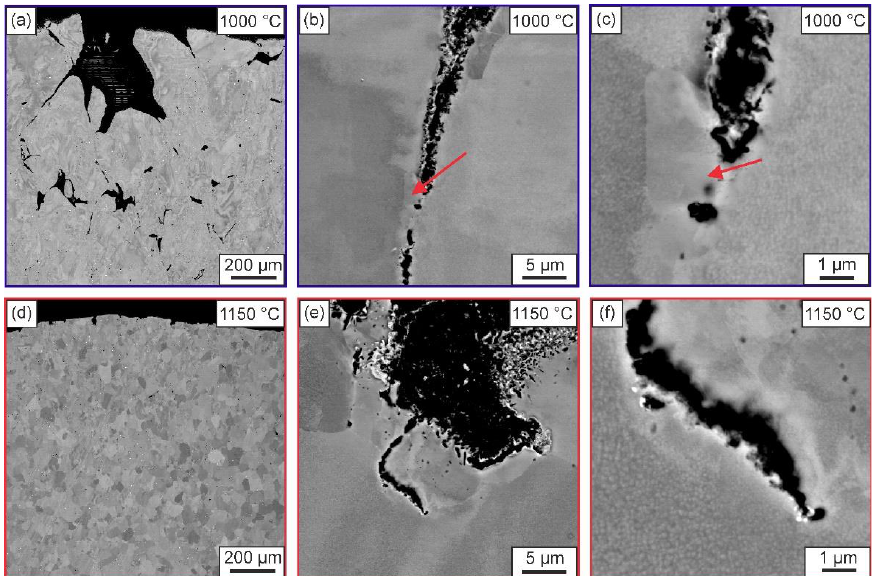
Figure 4. SEM images of the samples after deformation at a pre-heating temperature of 1100 °C, a strain rate of 10 −3 s −1 and a testing temperature of ( a – c ) 1000 °C and ( d – f ) 1150 °C. Red arrows indicate the partly recrystallized areas at the grain boundaries.